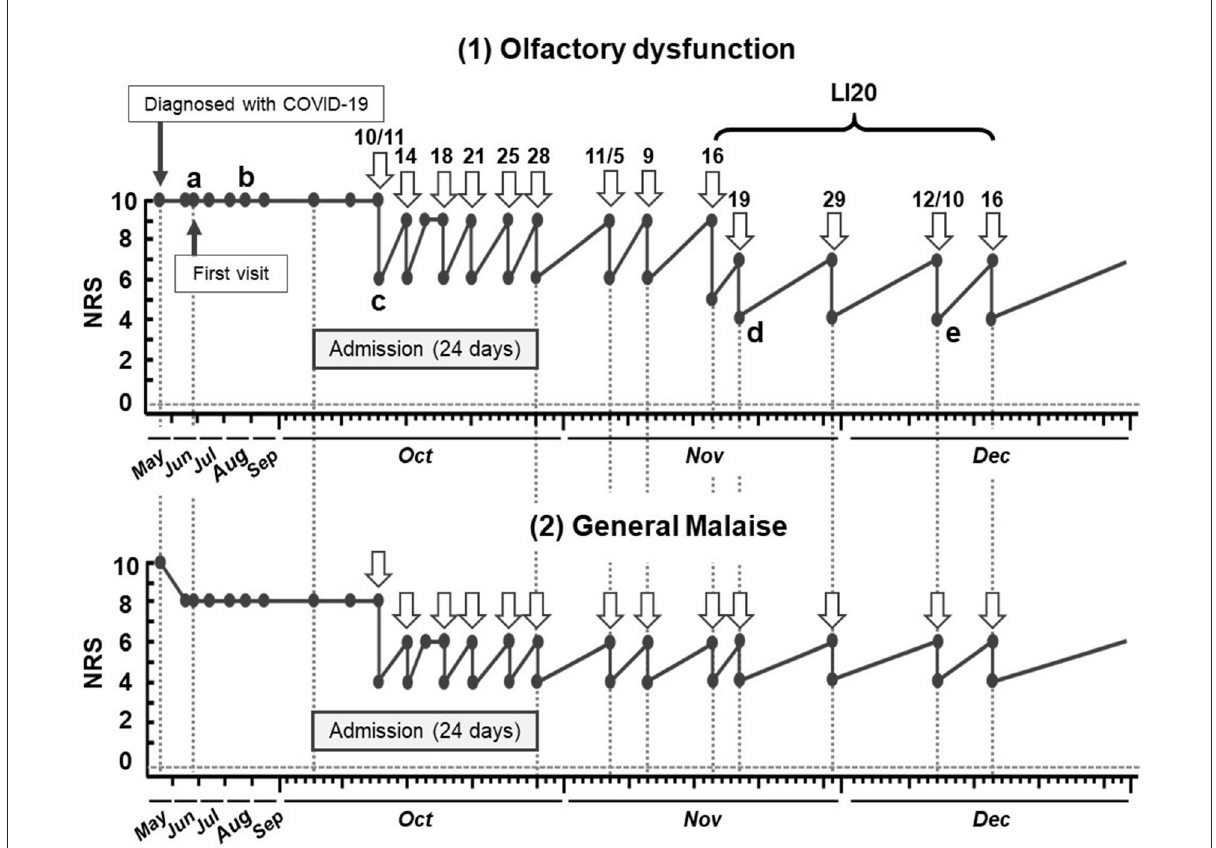
FIGURE2 Timeline of acupuncture treatment and subjective symptoms of olfactory dysfunction and general malaise in case 1. a. Difficult to smell. b. Cannot smell chlorine bleach (for cleaning) and does not feel well. c. Recognizes slight smell of sewage and the smell of coffee. d. Can smell own stool and ginger tea. e. Can smell sewage and herbs after treatment. NRS, numeric rating scale; COVID-19, coronavirus